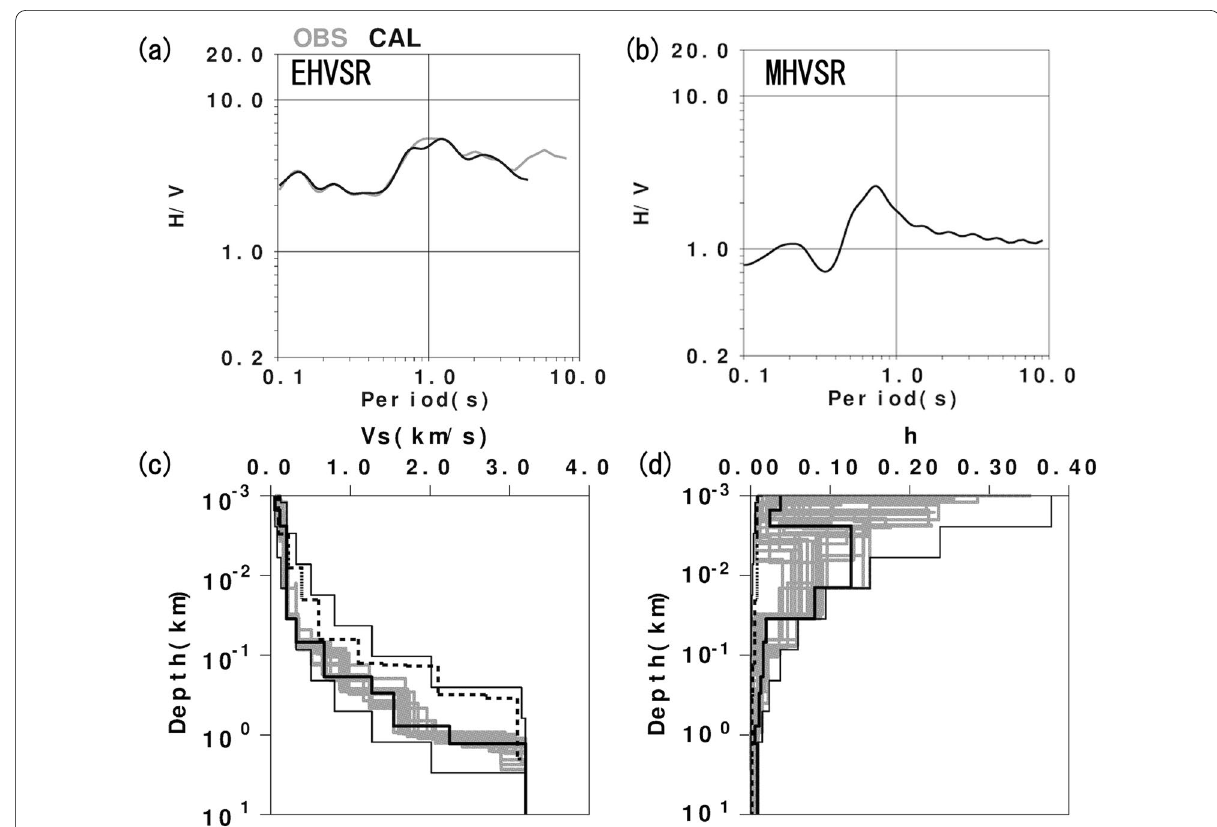
Fig. 3 Observed and calculated H / V of earthquake ground motion with estimated underground structures. a Observed (gray) and calculated (black) EHVSR at TTR002 site. b Observed MHVSR near the TTR002 site. c S wave velocity model with the results of 21 cases performed with different initial random numbers (gray lines), the most suitable solution (bold line) from which black line of ( a ) is calculated, and the search range (thin solid lines). Detailed parameters of the most suitable solution are shown in Additional file 1: Table S1. The dashed line indicates J-SHIS model